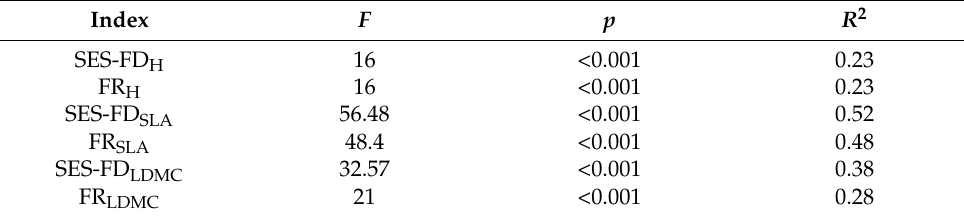
Table A1. Results of the ANOVA tests for standardized effect size of functional diversity (SES-FD) and functional redundancy (FR) considering the traits of (H) plant height, (SLA) specific leaf area and (LDMC) leaf dry matter content. Plant community type was the grouping factor (df = 3). Index F p R